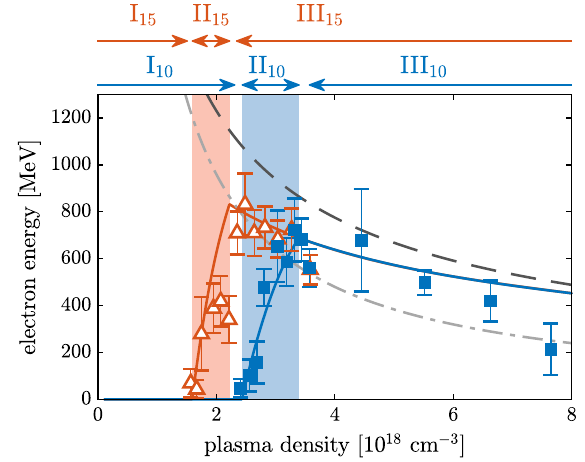
FIG. 3. Variation of W with n for 10 (squares) and 15 mm max e (triangles) gas jets. Each point is the mean from N ¼ 1 – 13 shots, and bars represent the combined statistical and measurement errors. Curves show the maximum energy predicted using Eqs. (1) (dot-dashed), (3) (dashed), and (4) for the 10 (blue) and 15 mm (red) nozzles. The regions (I, II, and III) described in the text are indicated for each nozzle. Region II for each nozzle is also indicated as a shaded